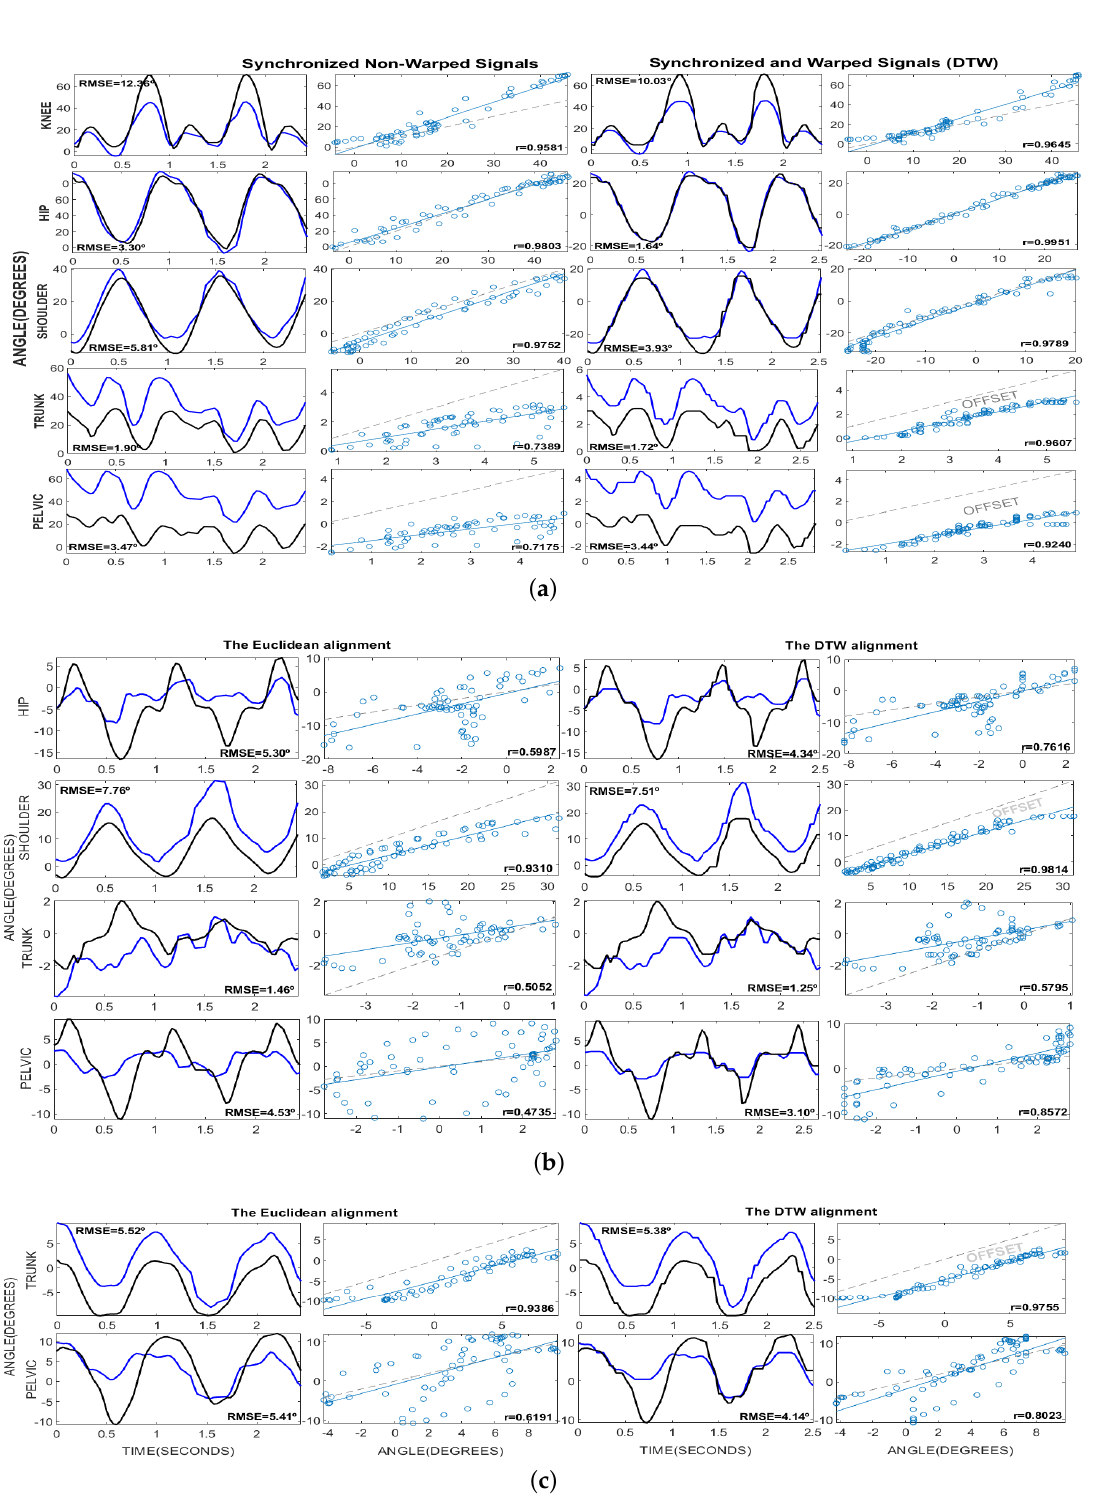
Figure 6. The kinematic angles for knee, hip, shoulder, trunk, and pelvis in ( a ) sagittal, ( b ) frontal, and ( c ) transverse planes reported from Vicon (black line) and Kinect (blue line) systems. There are four columns representing from left to right: The Euclidean alignment and the RMSE error. The scatter plot for this non-warped signals and Pearson correlation (r). The warped signals by using DTW alignment and the RMSE error. The scatter plot of this warped signals and the Pearson correlation (r). All these figures were made from one of the iterations gathered during the data collection. The warping constraint w was equivalent to 3